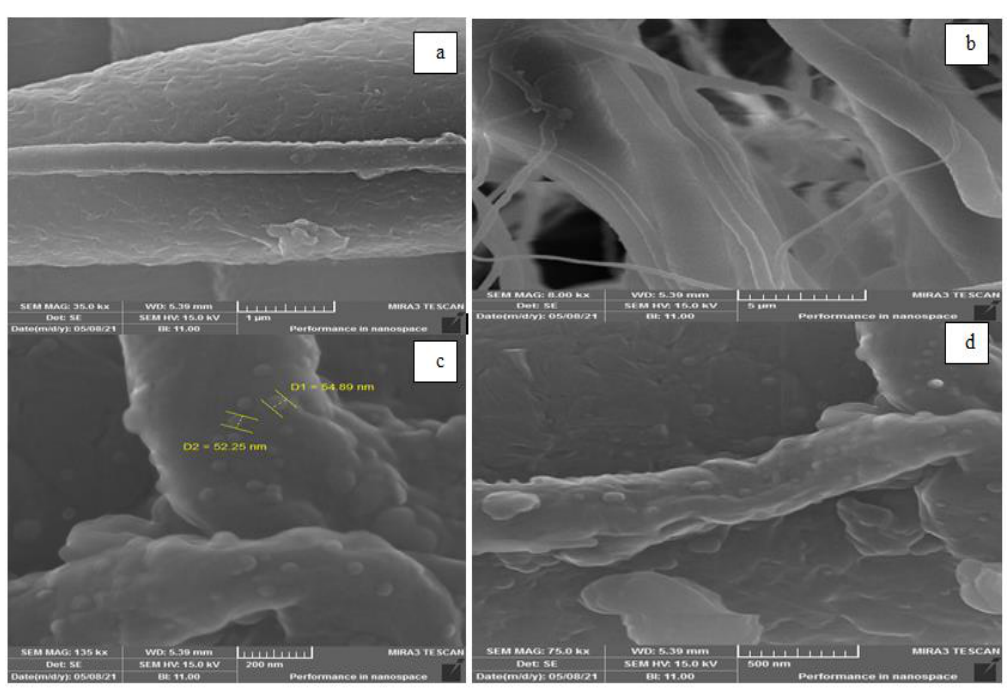
Figure 5: FESEM of pure fiber PCL at different